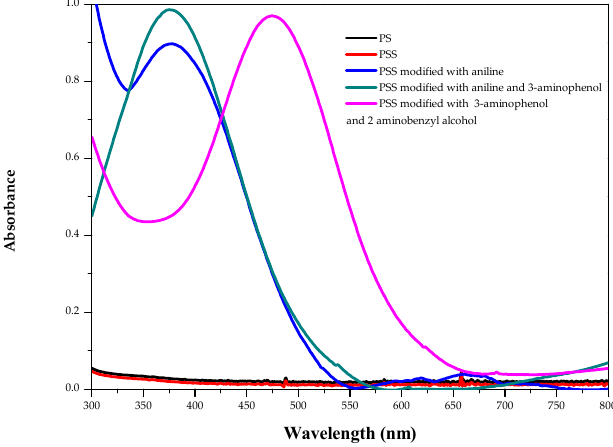
Figure 2. UV-visible spectra of unmodified and modified PS.